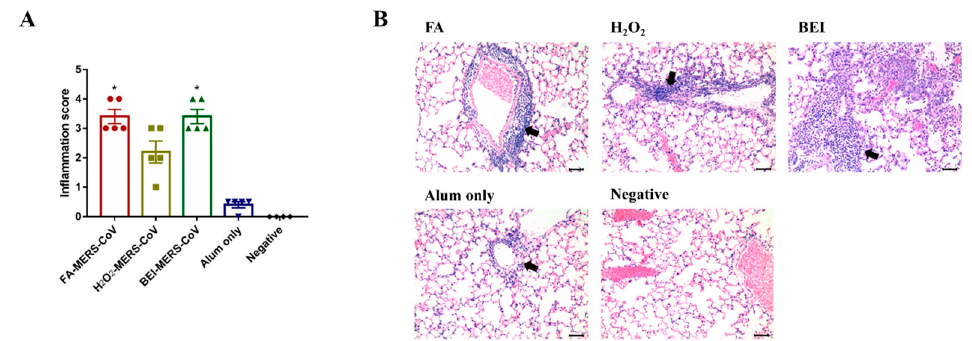
Figure 3. Histopathological changes in the lungs of immunized groups. ( A ) Inflammation score of lung pathology. ( B ) Representative results of hematoxylin-eosin (H&E) staining ( × 200) in the lungs of immunized mice, alum only (positive) or negative. Note the heavy infiltration of inflammatory cells around the blood vessels (arrows). Bars = 50 μ m. Data are represented as the mean ± S.E.M. * p < 0.05 compared with alum only.